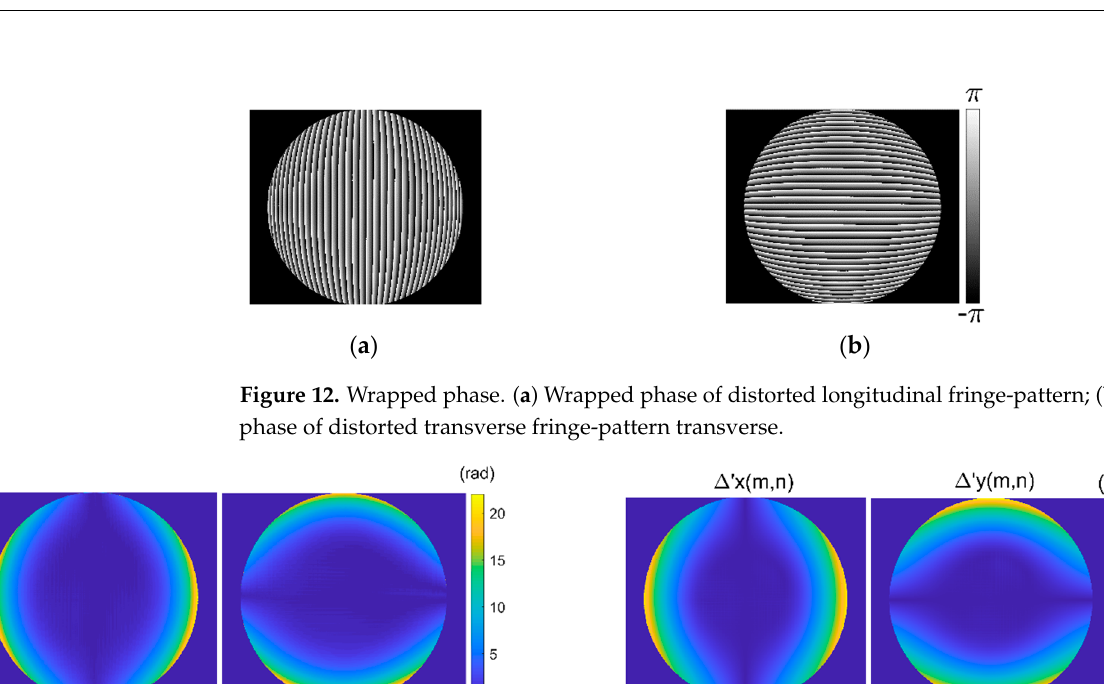
Figure 13. Modulated phase and distortion displacement map. ( a ) ∆ ϕ x ( x , y ) of size 2048 × 2448 pixels; ( b ) ∆ ϕ y ( x , y ) of size